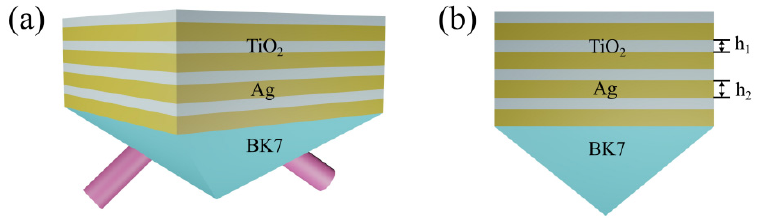
Figure 1. ( a ) 3D schematic diagram of the proposed SPR sensor. ( b ) The corresponding cross-section